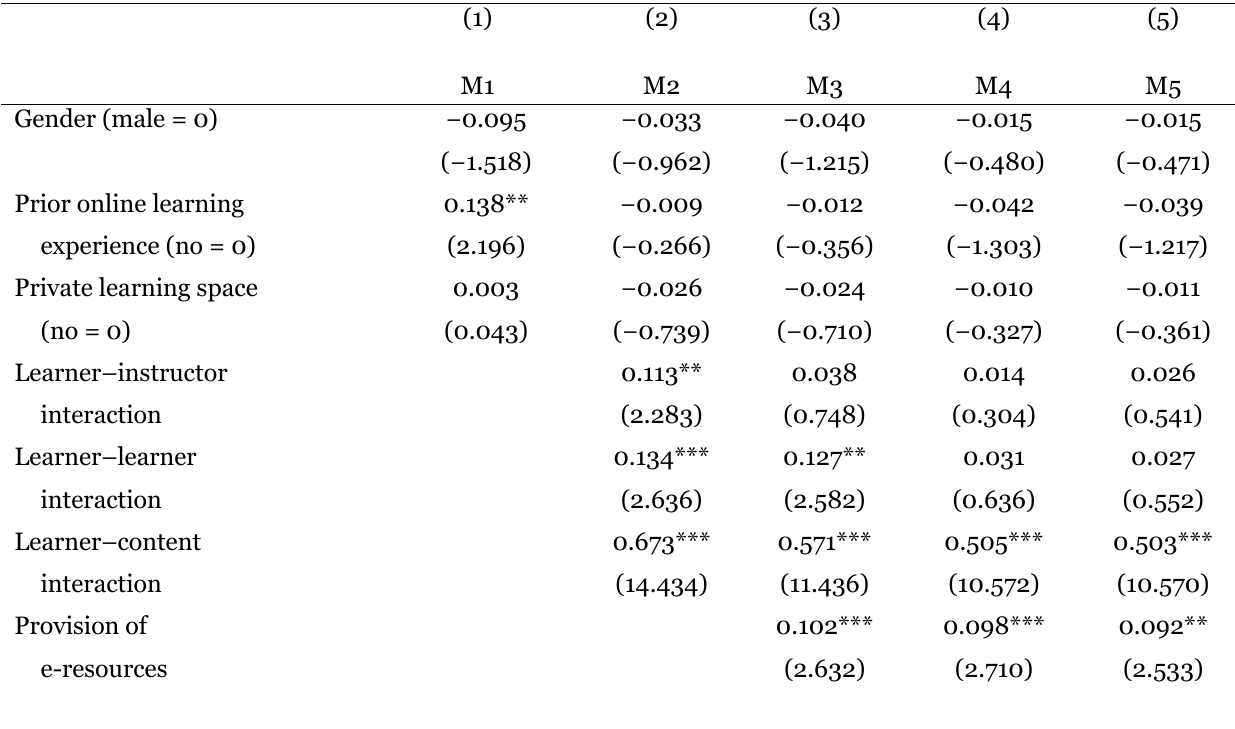
Regressions on Perceived Learning